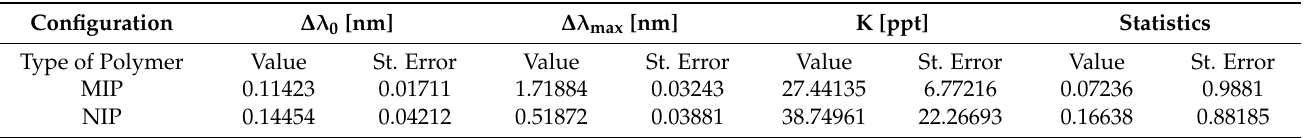
Figure 5. The absolute value of the resonance wavelength variations (calculated with respect to the blank) versus PFOA concentration in Milli-Q water, with the error bars and Langmuir fitting in semi-log scale for MIP and NIP sensor configurations. Table 1. The Langmuir fitting parameters relative to PFOA detection by the MIP and NIP sensor